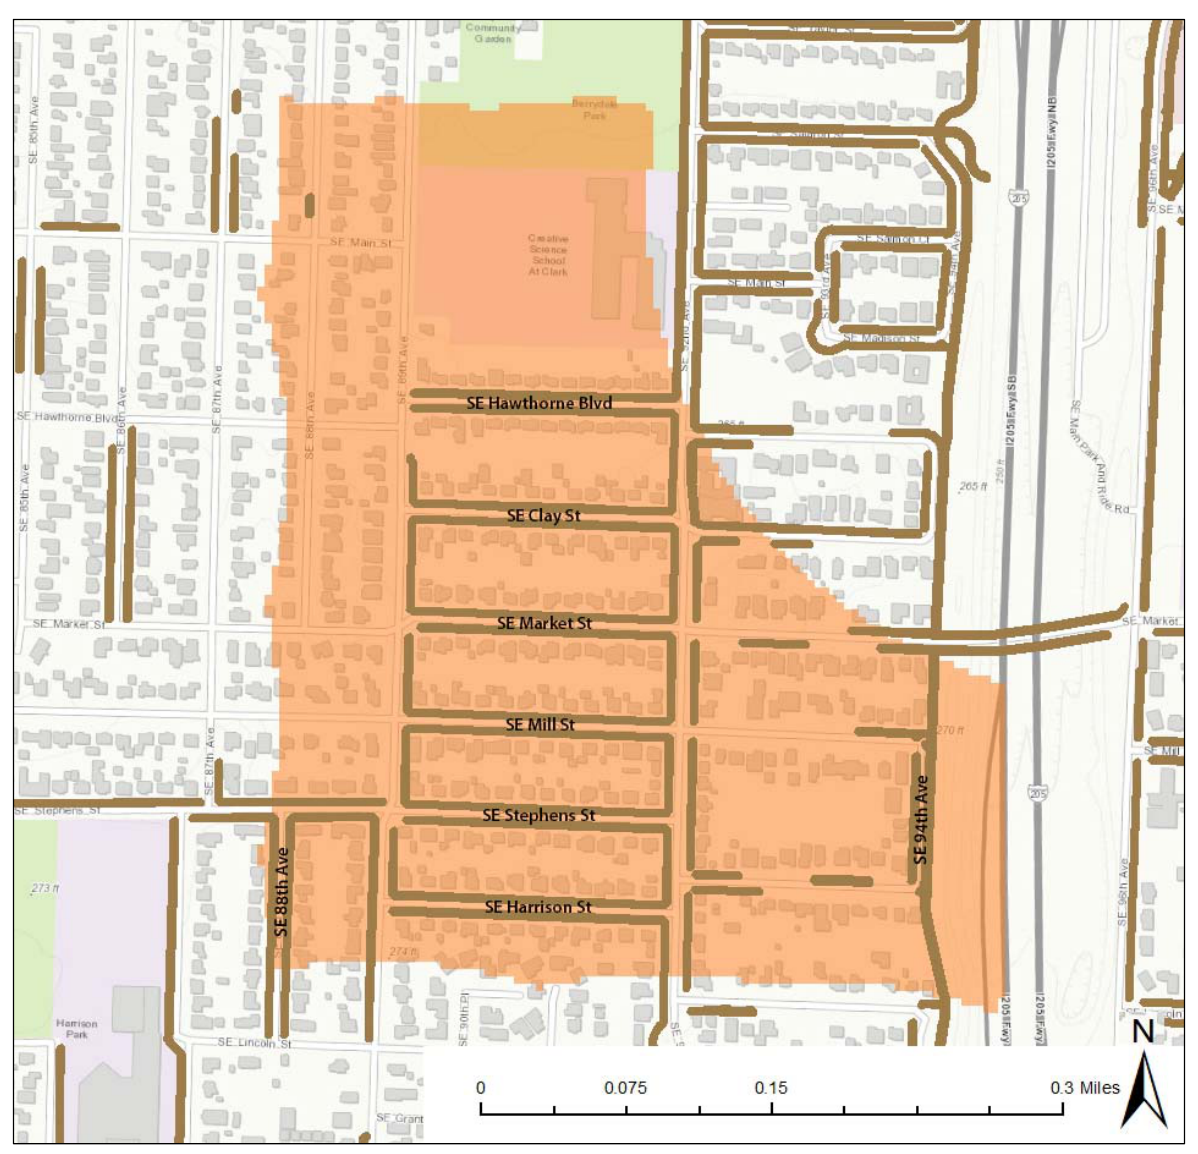
Figure 11. Highlighted Area in Southeast Portland. This area from SE 88th Avenue to SE 94th Avenue and SE Salmon Street to SE Harrison Street contains Berrydale Park as well as the Creative Science School at